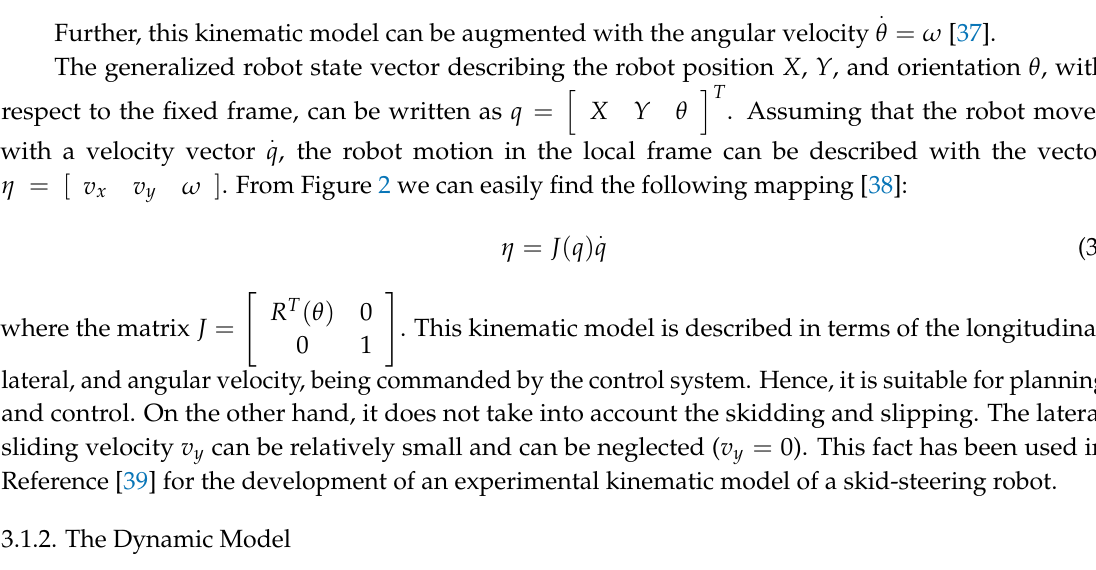
Figure 2. A skid-steered vehicle on a circular path.